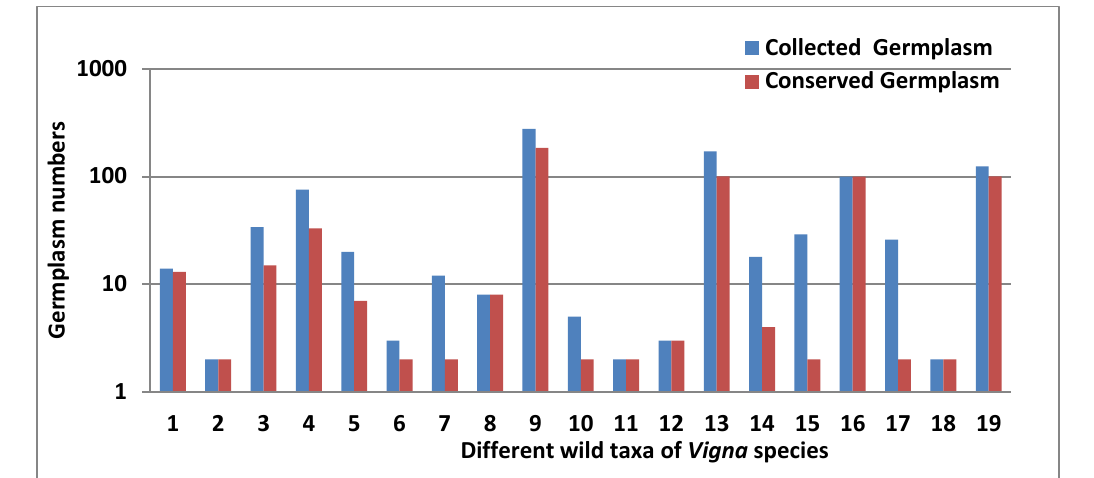
Figure 2. Wild taxa of the Vigna germplasm collected and conserved in INGB (1976–2021) based on a log scale with a base of 10. 1— Vigna angularis var. nipponensis , 2— V . adenantha , 3— V . bourneae , 4—